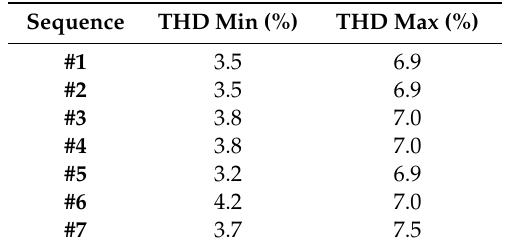
Table 8. THD range maximum and minimum values with random time-varying harmonic distorted current and voltage